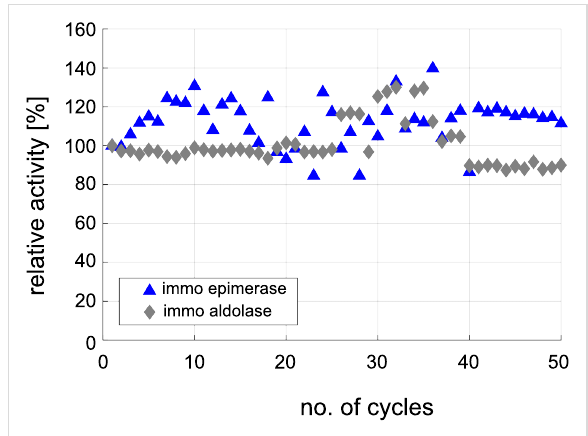
Figure 7: Recycling study of immobilized epimerase and aldolase. Assay conditions: 100 mM Tris, pH 8, 40 °C, shaking with 1000 rpm, V = 1 mL. Between the batches the carrier was washed with 100 mM Tris pH 8 and stored until the next application at 4 °C. Reaction condi- tions: (i) immo epimerase: 100 mM N -acetyl - ᴅ - glucosamine, 1 mM ATP, 1 mM MgCl 2 , 10 g carrier /L, loading: 37.6 mg enzyme /g carrier ; (ii) immo aldolase: 100 mM N -acetyl - ᴅ -mannosamine, 250 mM pyru- vate, 70 g carrier /L, loading: 95.0 mg enzyme /g carrier .